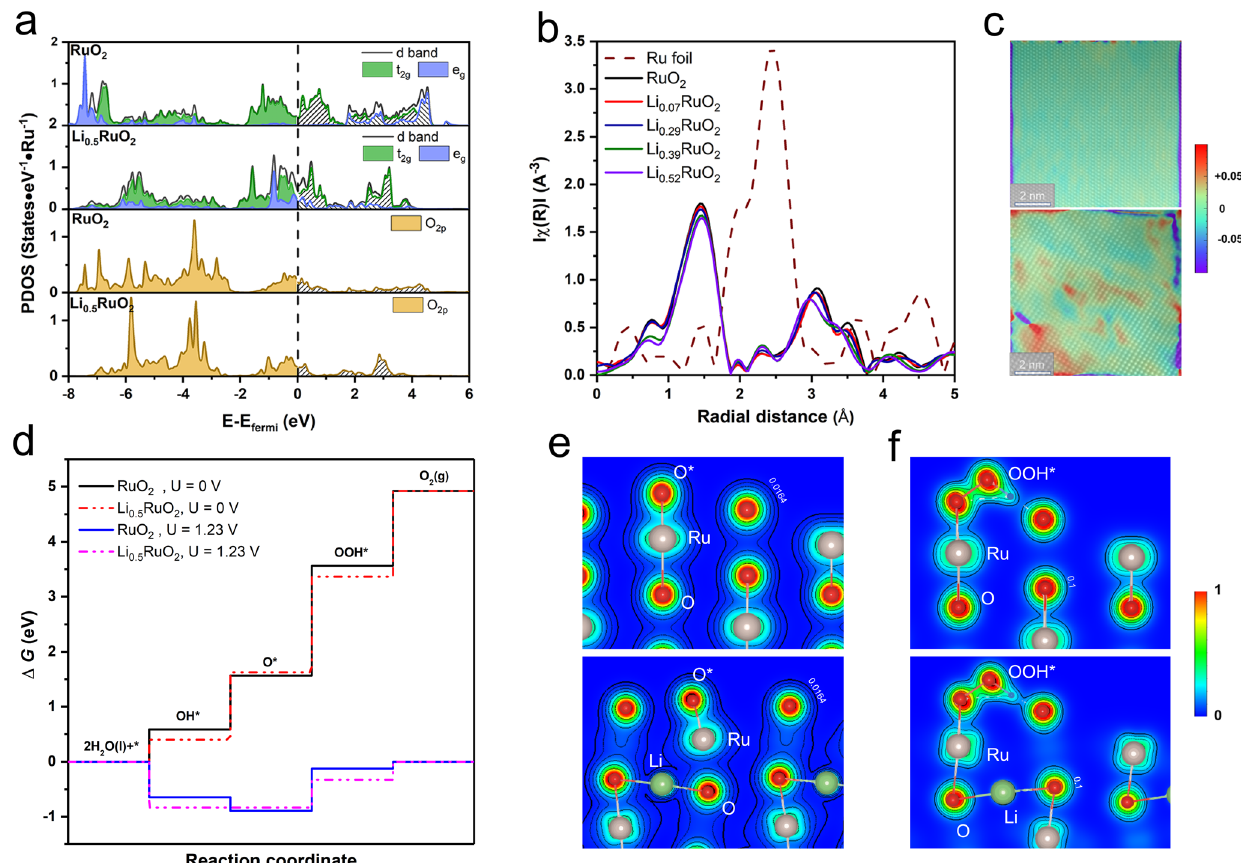
Fig. 3 OER mechanism analysis. a PDOS of the RuO 2 and Li 0.5 RuO 2 . b Fourier-transformed Ru K-edge extended X-ray absorption fi ne structure (EXAFS) spectra. c Lattice strain ( ε xx ) measured from geometric phase analysis (GPA) of atomic-resolution HAADF − STEM images (Fig. 1f) for RuO 2 (up) and for Li 0.56 RuO 2 (down). d Calculated OER free-energy diagrams for RuO 2 and Li 0.5 RuO 2 . e The charge density distribution of the O* absorbed on the (110) surface of RuO 2 (Up) and Li 0.5 RuO 2 (down). The outermost black curve corresponds to the charge density of 0.0164 e − /Bohr 3 . f The charge density distribution of the OOH* absorbed on the (110) surface of RuO 2 (up) and Li 0.5 RuO 2 (down). The outermost black curve corresponds to the charge density of 0.1 e − /Bohr 3